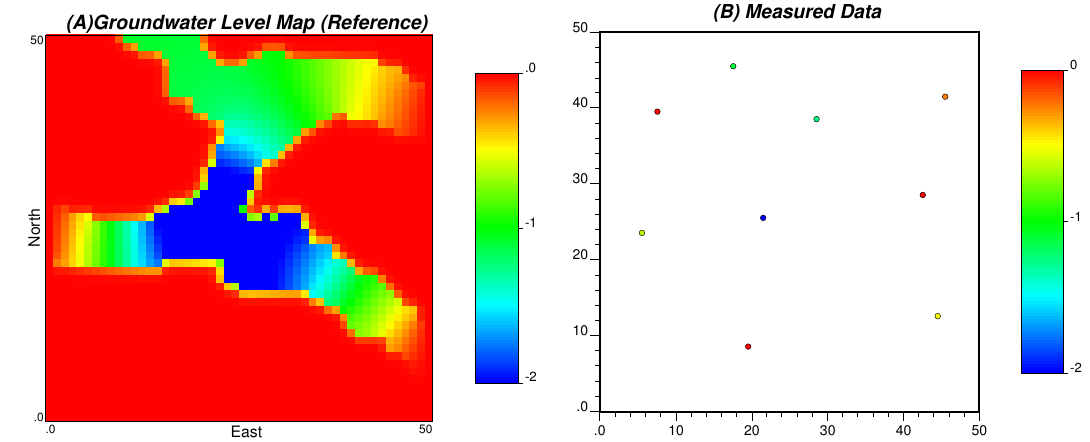
Figure 4. ( A ) Groundwater level map for the reference field at time ( t = 1.3 days); and ( B ) measured data from nine